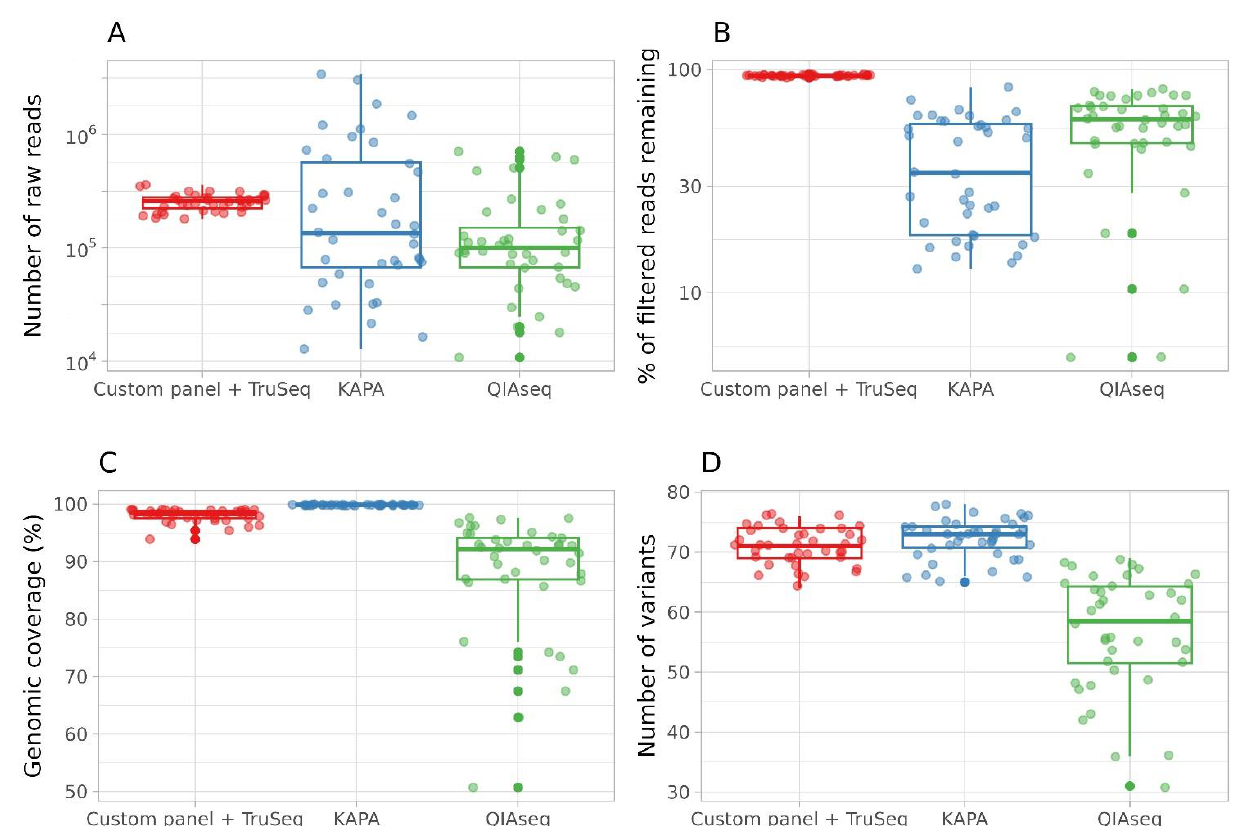
Figure 2. Comparison of the different library preparation kits. The x -axis shows the method. show: ( A )—number of raw reads achieved after Illumina MiSeq sequencing ( y -axis is lg scaled); Boxplots show: ( A ) — number of raw reads achieved after Illumina MiSeq sequencing ( y -axis is lg ( B )—percent reads remaining after QC-trimming; ( C )—percent SARS-CoV-2 genomic coverage; scaled); ( B ) — percent reads remaining after QC-trimming; ( C ) — percent SARS-CoV-2 genomic ( D )—number of identified SNPs. Key: red—TruSeq DNA Nano Library Kit with custom primer coverage; ( D ) — number of identified SNPs. Key: red — TruSeq DNA Nano Library Kit with custom panel; blue—KAPA HyperCap SARS-CoV-2; green—QIAseq DIRECT primer panel; blue — KAPA HyperCap SARS-CoV-2; green — QIAseq DIRECT SARS-CoV-2.